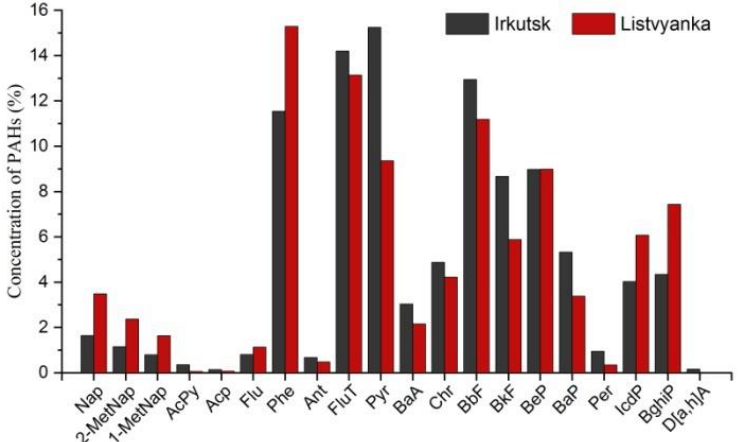
Figure 3. Average percentage of individual PAHs in aerosols at stations Irkutsk and Listvyanka (Southern Baikal region) from 2015 to